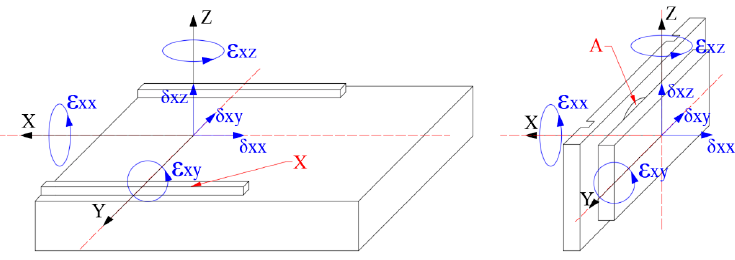
Figure 2. Complete geometric errors of the X-axis and the A-axis.